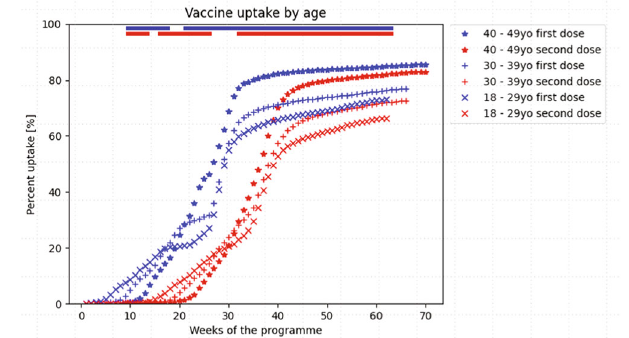
Fig. 1 | COVID-19 vaccine uptake by age, normalised for date of vaccine avail- ability by age group (thus, week 26 represents the week for universal age- tiered vaccination offer for all women of reproductive age groups). The non- parametric Mood ’ s median test was used to compare the time to vaccination tra- jectories by age grouping; a two-sided P value was considered to be statistically signi fi cant was <0.001, corrected for multiple testing using the conservative Bon- ferroni correction (i.e., 5.38×10 − 6 for age); signi fi cance by week is represented by thecolouredbaratthetopoftheFigures.Thebarsatthetopofthe fi gurerepresent the time periods during which there were signi fi cant differences in vaccine uptake byage,atthe P <5.38×10 − 6 level.Bluebarsrepresentthe fi rstvaccinationdose,and red bars second vaccination dose. It was not feasible to present 95% CI for vaccine uptake trajectories and maintain readability, but the statistical analyses accounted for trajectory variability within